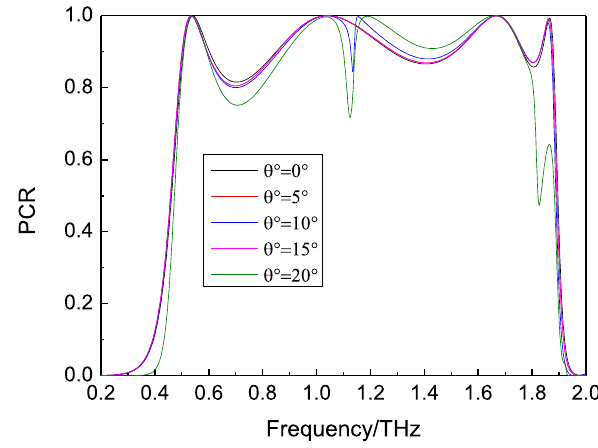
Fig. 6 Relationship between PCR and incident